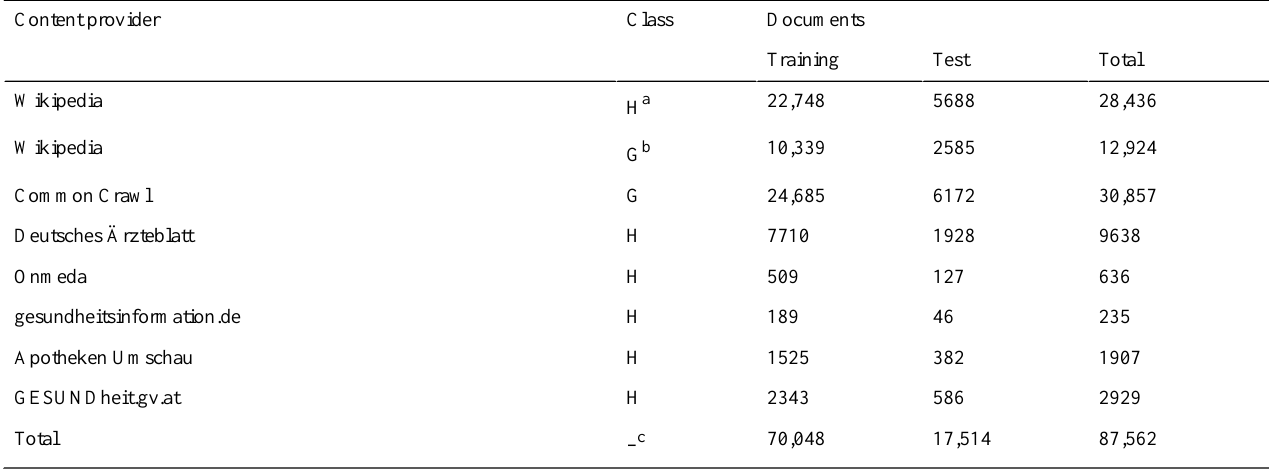
Table 2. Total amount of articles used in the training and test corpus per content provider with corresponding class labels: health-related language (H) and general language